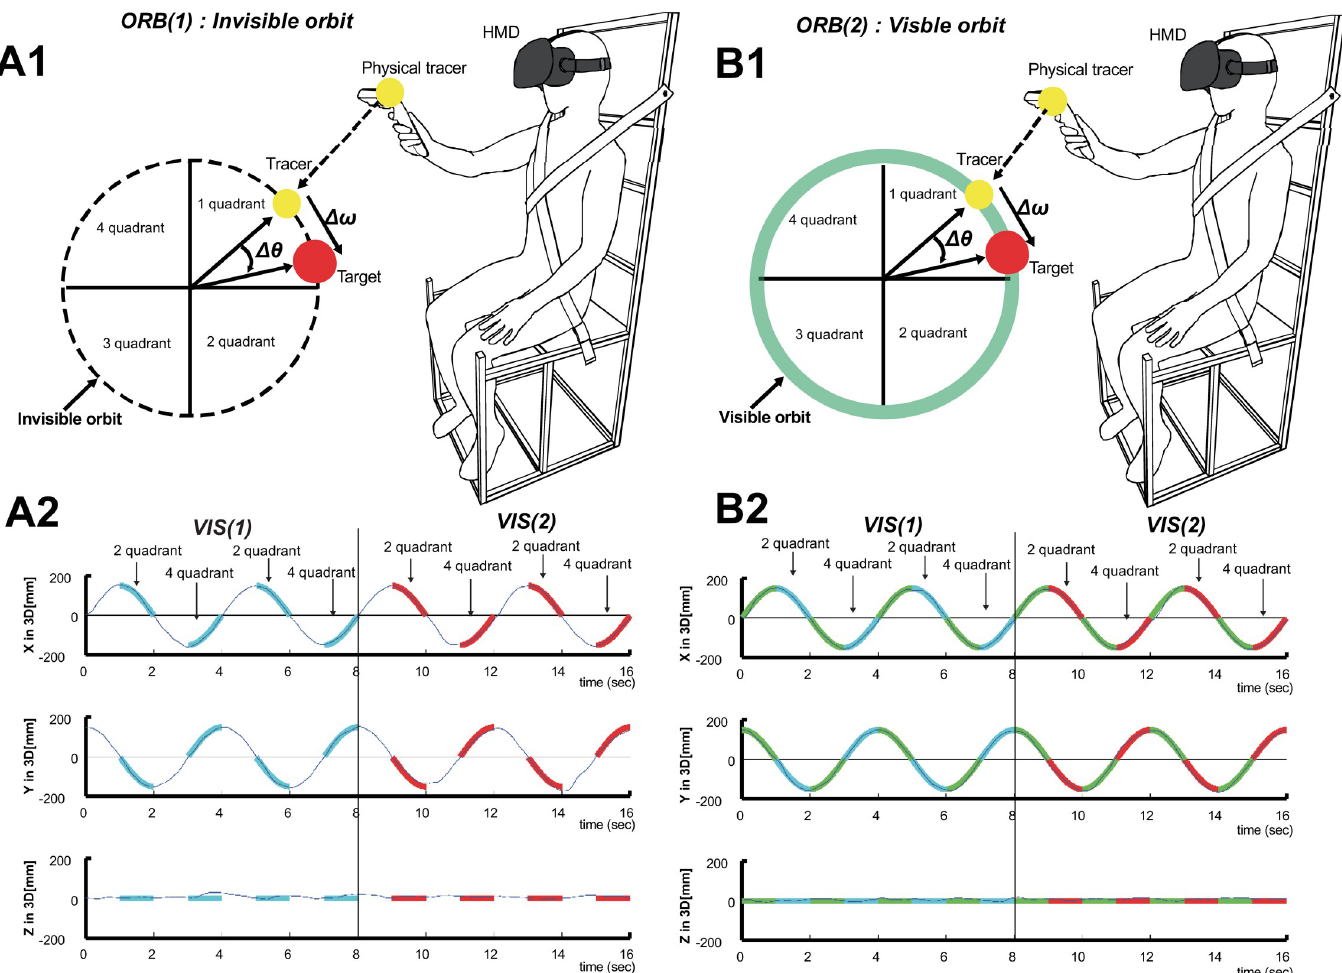
Fig 1. Experimental procedure. VIS(1) : visible target and tracer, VIS(2) : only visible tracer. ORB(1) : invisible circular orbit, ORB(2) : visible circular orbit. (A1) Schematic of circular tracking experiment for ORB(1) . Under ORB(1) , the target path is not visible to the subjects during the experiment. (B1) Schematic of circular tracking experiment for ORB(2) . Under ORB(2) , the target path is visible to the subject. The green lines indicate the target path in the 3D VR space. The insets on the left-hand sides of (A1) and (B1) show how the two outcome measures ( Δ θ , Δ ω ) were derived from the path data of the target (or tracer) under each condition. In both (A1) and (B1), the target rotates clockwise at a constant speed, moving from quadrants 1 to 4 in order. (A2) Typical trial data showing tracer path (black line) versus time at a speed of 0.25 Hz on three axes. (B2) Typical trial data showing target (green line) and tracer paths (black line) versus time at a speed of 0.25 Hz on three axes. The three graphs in (A2) and (B2) show the path of the tracer as seen from the X-, Y-, and Z-axes, respectively. In the graphs, regions VIS (1) and VIS (2) are indicated in cyan and red,